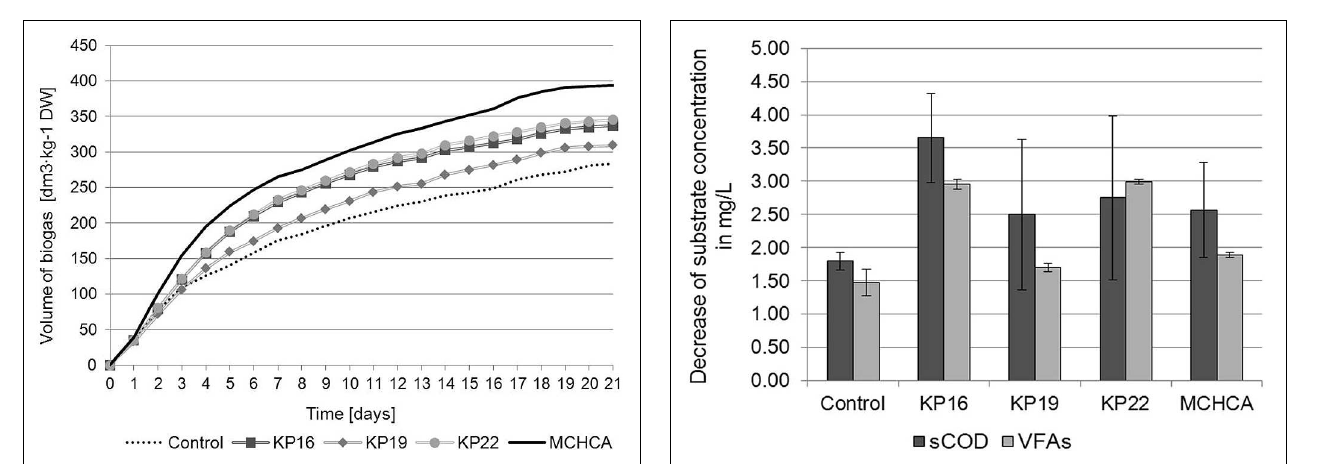
FIGURE 6 | Decrease of sCOD and VFAs concentration during biogas production (anaerobic digestion) from maize